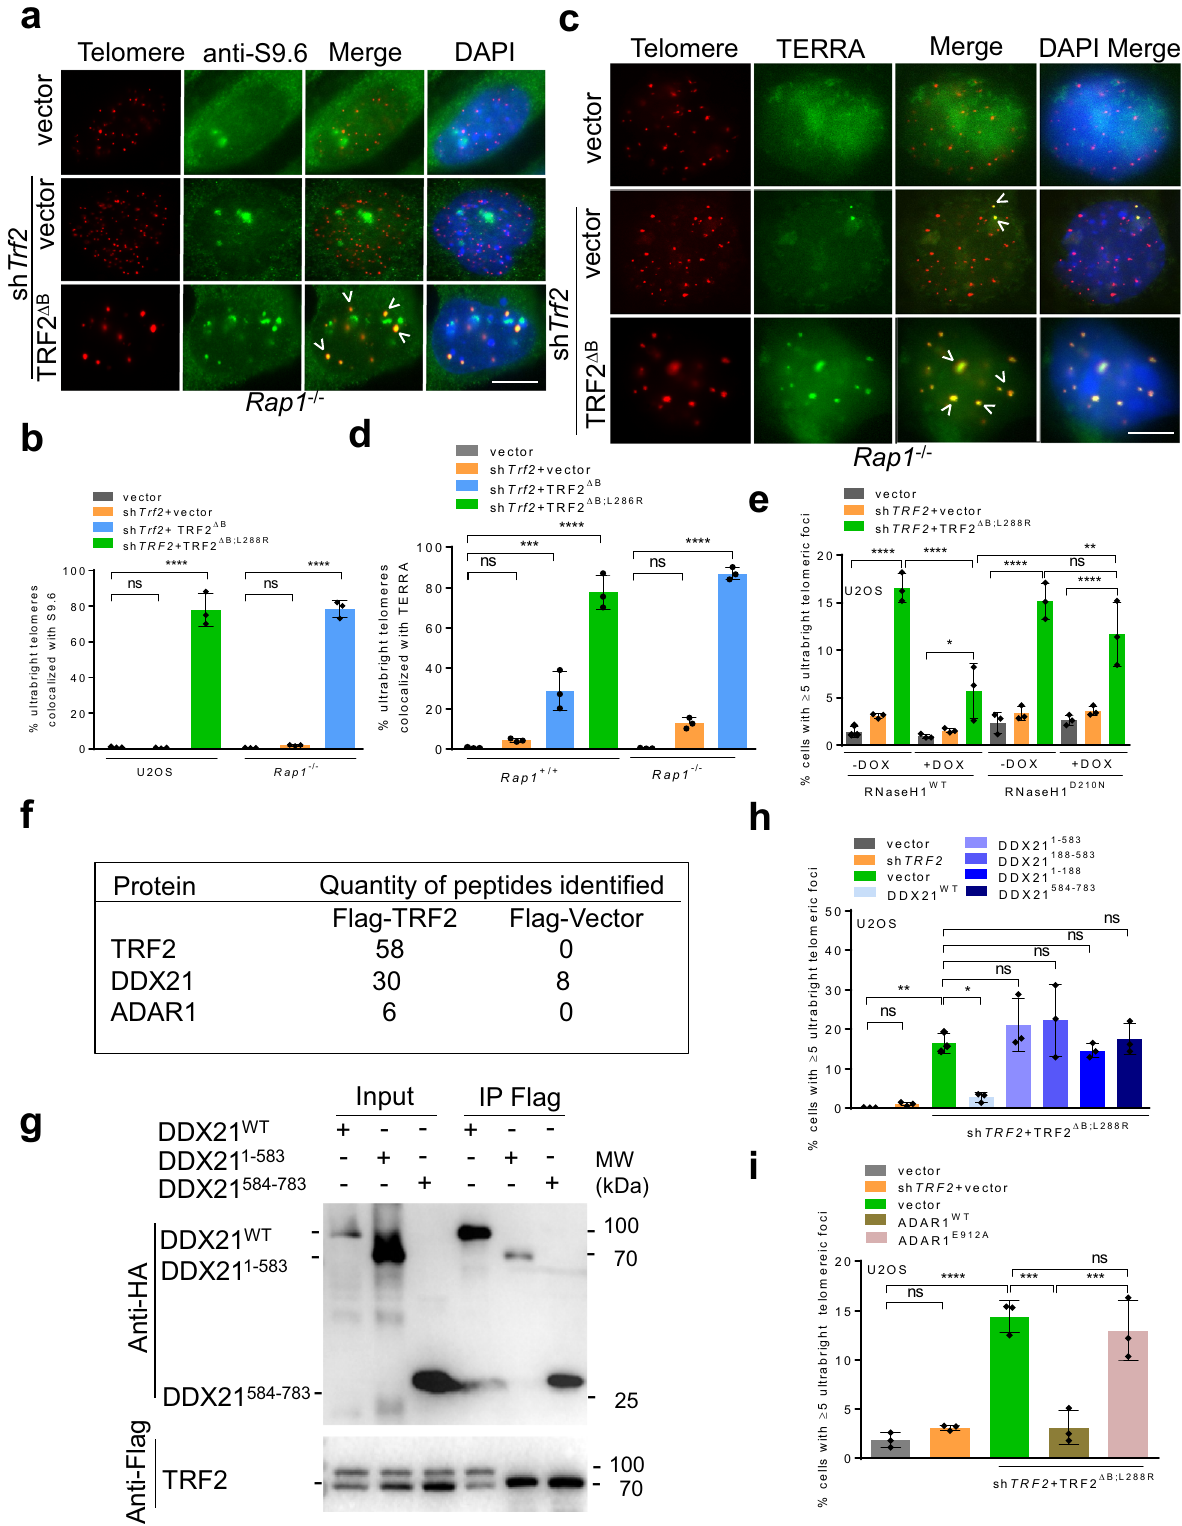
DNA-RNA hybrids impairs replication/transcription machineries 85 – 89 . R-loops are sources of replication stress and the ATR-CHK1 pathway